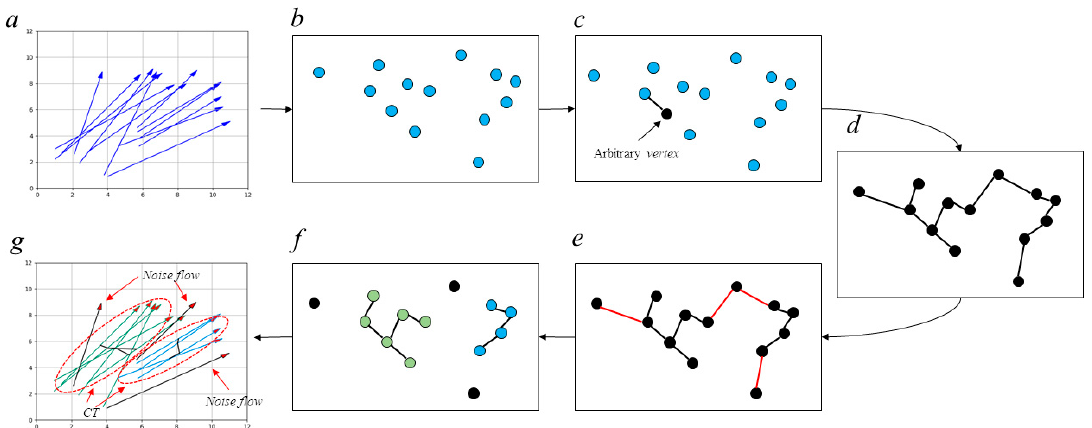
Figure 3 . Schematic illustration of the method for constructing a maximum spanning tree ( MST ) and its child trees ( CTs ): ( a ) The original OD flows; ( b ) Treating the OD flows as vertices ; ( c ) Constructing the MST starts with an arbitrary vertex and finding the heaviest edge that connects the MST and an isolated vertex step by step; ( d ) the MST ; ( e ) Finding the inappropriate edges ; ( f ) Removing the inappropriate edges ; ( g ) the CTs and noise